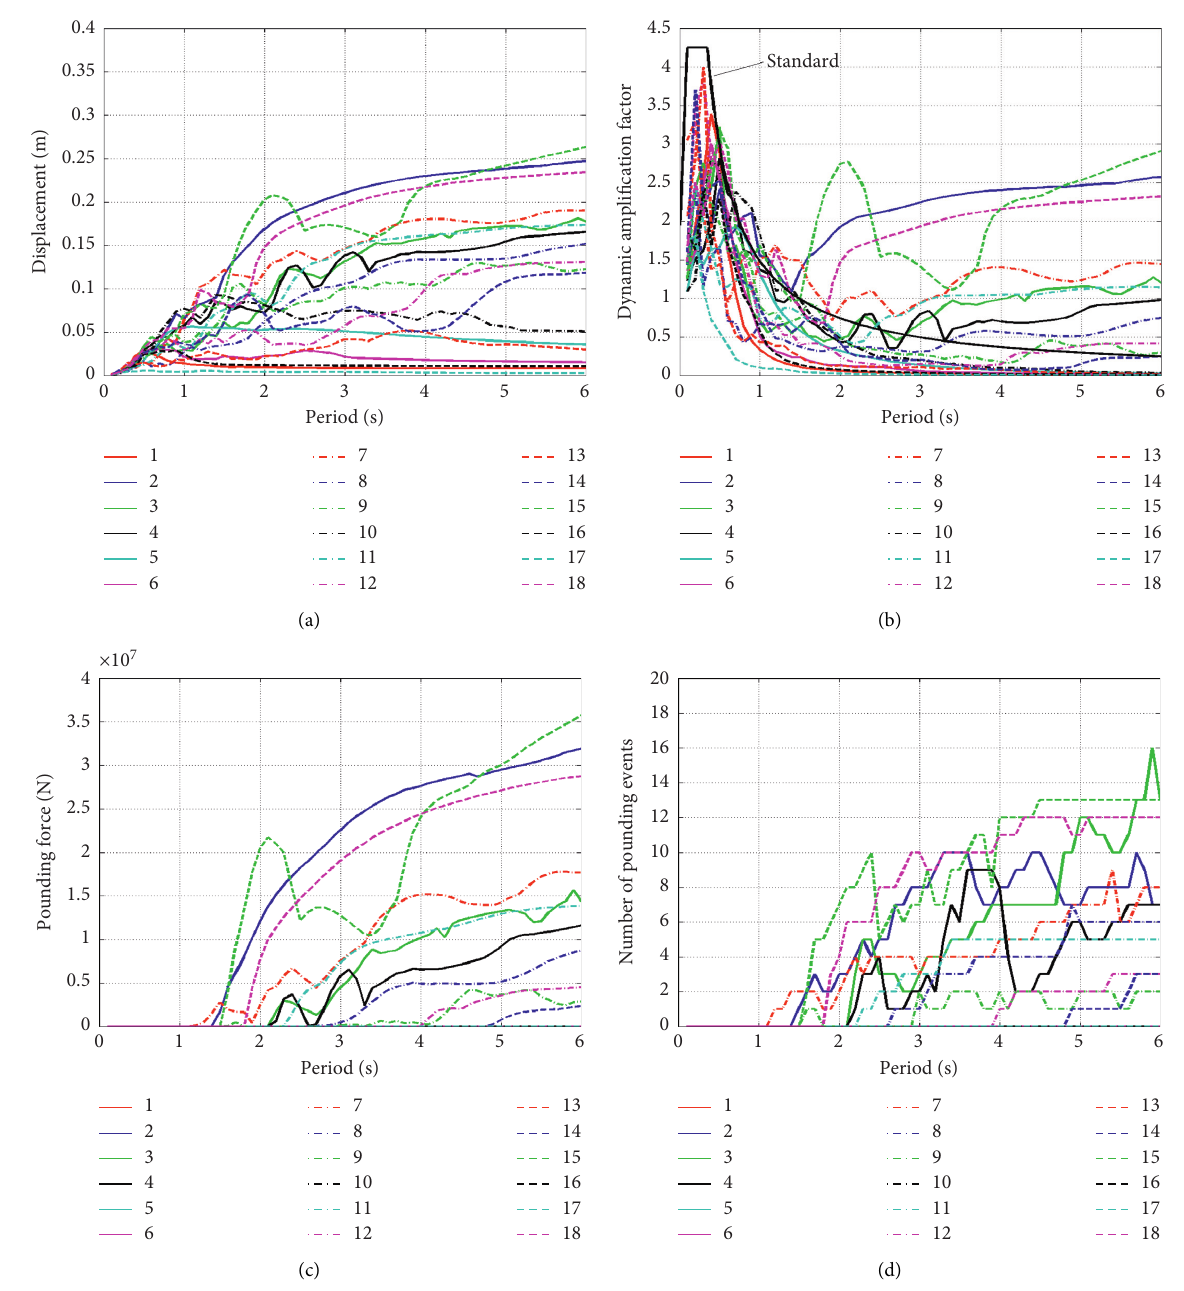
Figure 10: Analytical results considering pounding. (a) Displacement spectrum. (b) Dynamic amplification factor spectrum. (c) Pounding force spectrum. (d) Number of pounding event response